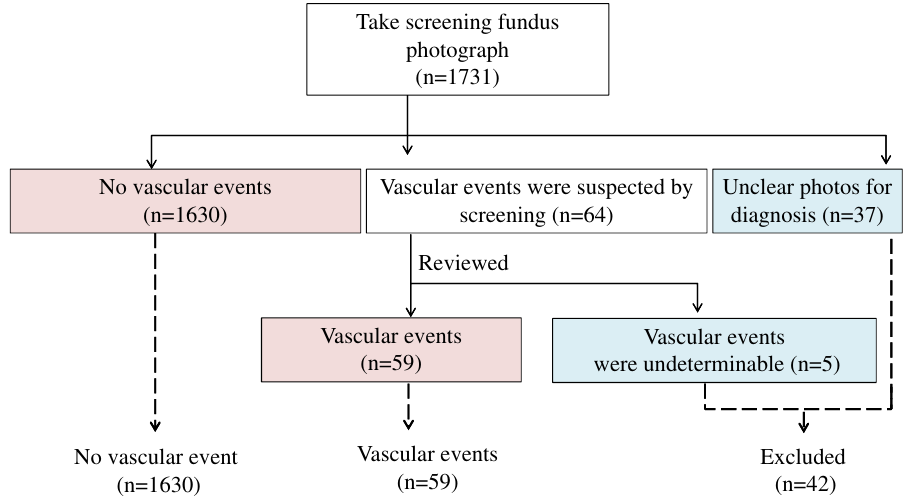
Figure 1. Summary of the participant groups included in the study. Among the 1731 participants, 37 were excluded because of unclear photographs that could not be used to diagnose pathological findings requiring further investigation. Suspected findings of retinal vascular events were identified in fundus photographs of 64 participants by the initial screening. Further reviews of the participants’ photographs led to the exclusion of five participants because their findings were indistinguishable from changes other than vascular events such as pigmentations. Finally, we included 1630 in the no-retinal vascular event group and 59 in the retinal